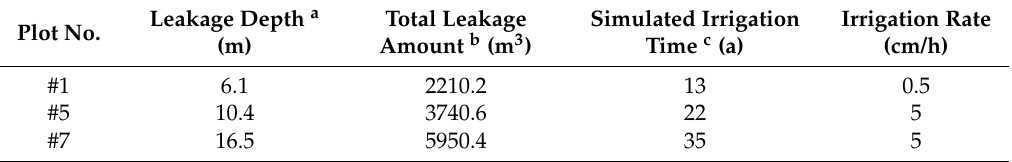
Table 1. The data of the in-situ experiment.